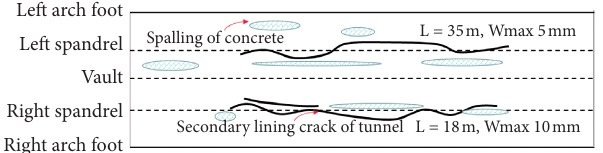
Figure 6: Location of cracks and concrete spalling in tunnel secondary lining.